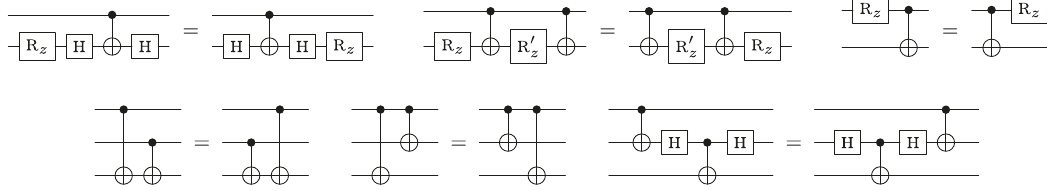
Fig. 5 Commutation rules. Top: Commuting an R z gate to the right. Bottom: Commuting a CNOT gate to the